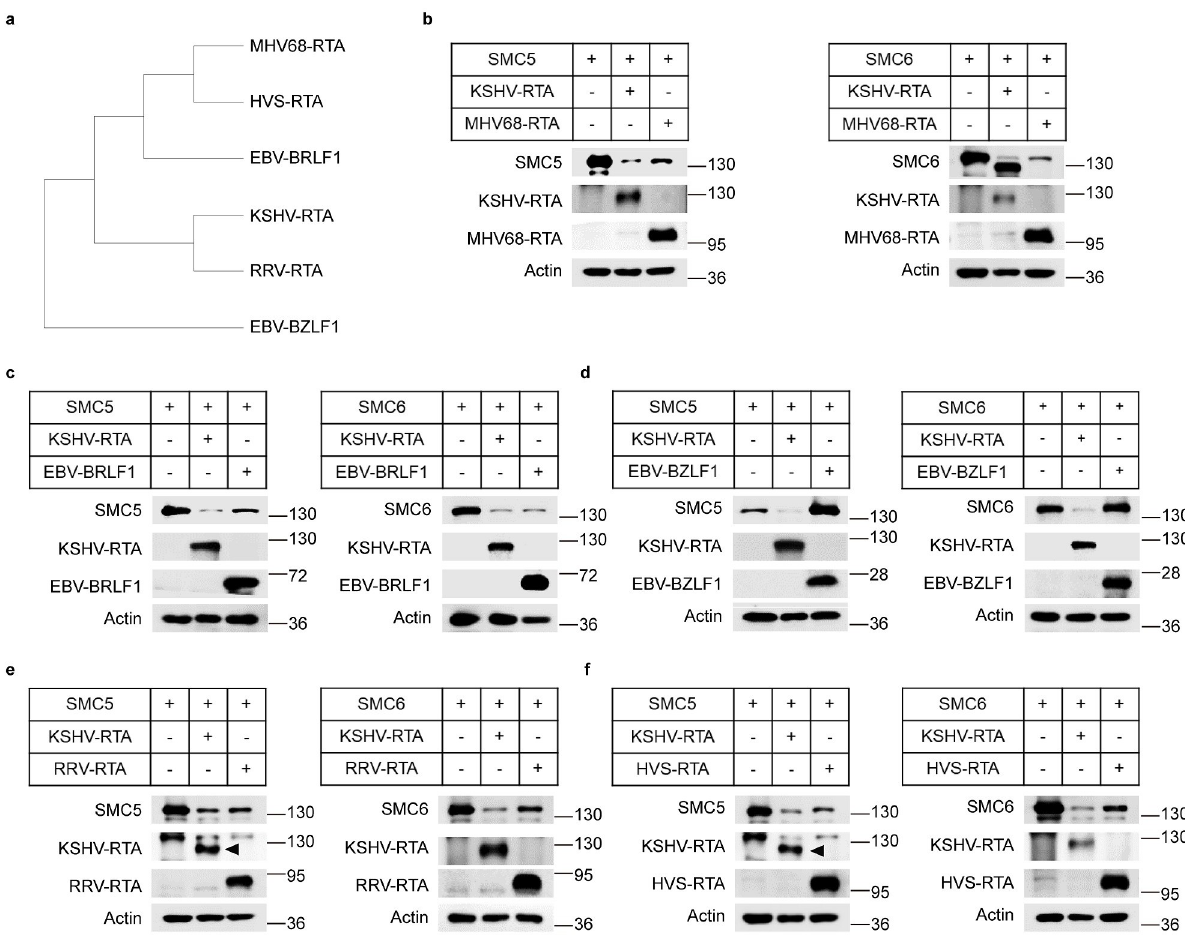
Fig 8. RTA-induced degradation of the SMC5/6 complex is evolutionarily conserved in γ -herpesviruses. (a) Phylogenetic analysis of the RTA proteins of γ -herpesviruses and EBV transcription-activator BZLF1. Phylogenetic analysis was performed using all amino acid sequences alignment obtained from ClustalX and the tree was built with MEGA_X_10.2.6. (b) MHV68-RTA degrades SMC5 (left) and SMC6 (right). HEK293T cells were transfected with SMC5 or SMC6 alone, SMC5 or SMC6 together with KSHV-RTA, SMC5 or SMC6 together with MHV68-RTA. 36h post- transfection, the cells were lysed and detected by western blots with indicated antibodies. (c) BRLF1 of EBV degrades SMC5 (left) and SMC6 (right). (d) EBV transcription-activator BZLF1 does not degrades SMC5 (left) and SMC6 (right). (e) RTA of RRV degrades SMC5 (left) and SMC6 (right). (f) RTA of HVS degrades SMC5 (left) and SMC6